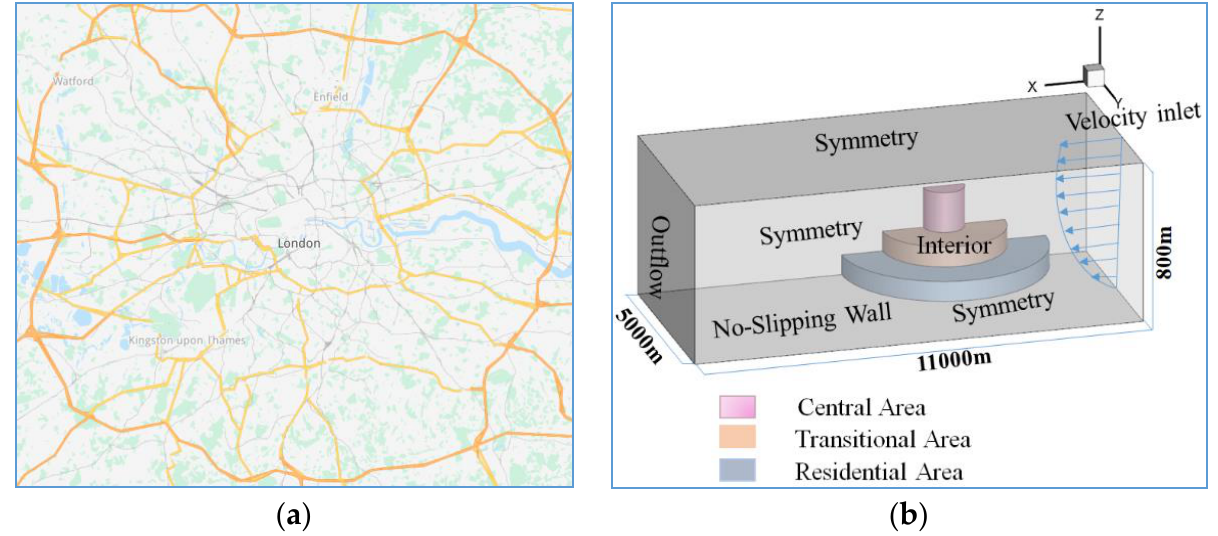
Figure 1. The evolution of the geometric model: ( a ) Map of London; ( b ) three-dimensional geometric model and boundary conditions.